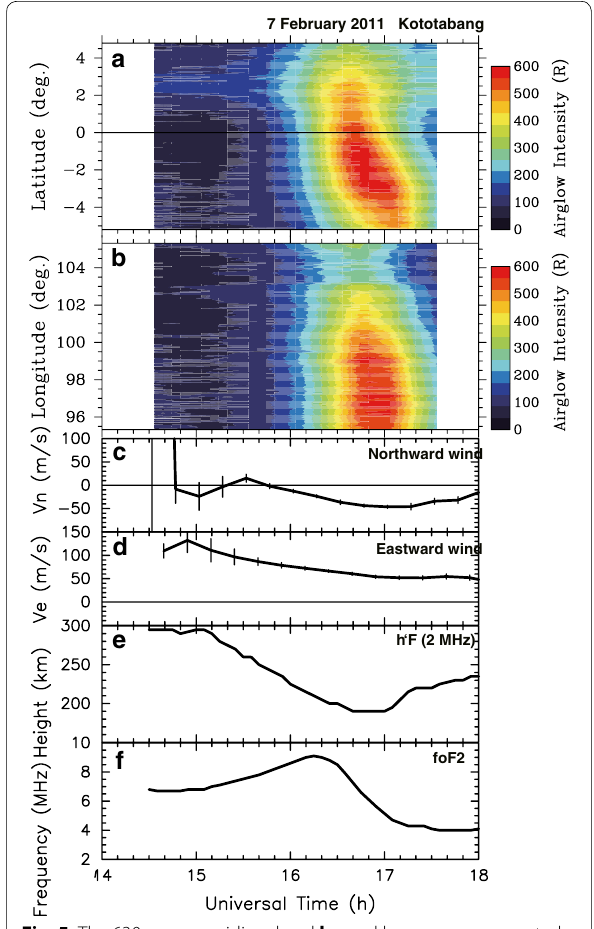
Fig. 5 The 630-nm a meridional and b zonal keograms represented as absolute airglow intensity, averages and standard deviations of c northward and d eastward neutral wind velocities observed by an FPI, e virtual heights at a frequency of 2 MHz ( h ′ F ) and f F2-region critical frequency ( f o F 2 ) observed by an ionosonde, at Kototabang on